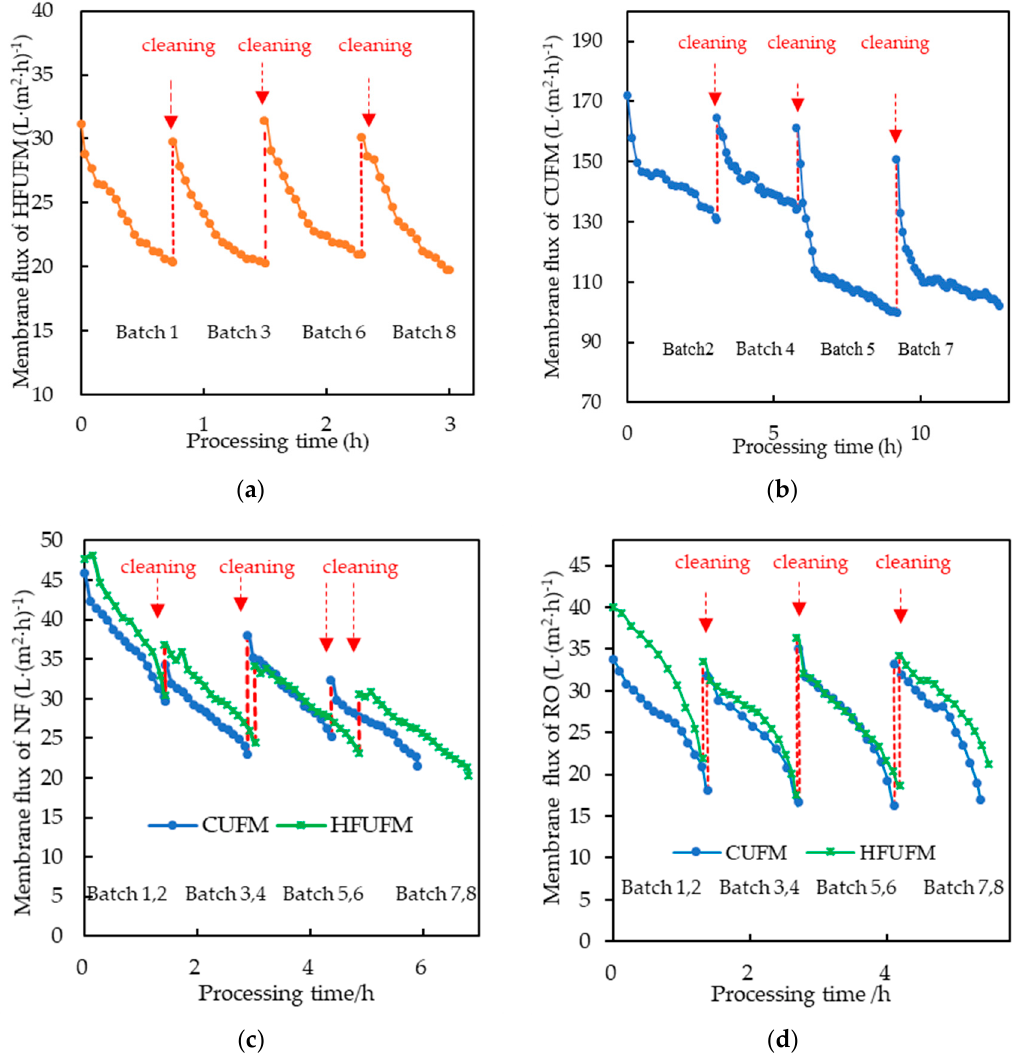
Figure 2. Membrane flux changes of ( a ) HFUFM pretreatment, ( b ) CUFM pretreatment, and ( c ) Figure2. Membranefluxchangesof( a )HFUFMpretreatment,( b )CUFMpretreatment,and( c )nanofiltration nanofiltration membrane (NF), ( d ) reverse osmosis (RO) process with HFUFM and CUFM membrane (NF), ( d ) reverse osmosis (RO) process with HFUFM and CUFM pretreatment pretreatment method. Table 3. Studies applied HFUFM or CUFM process to pretreating the biogas digestate.